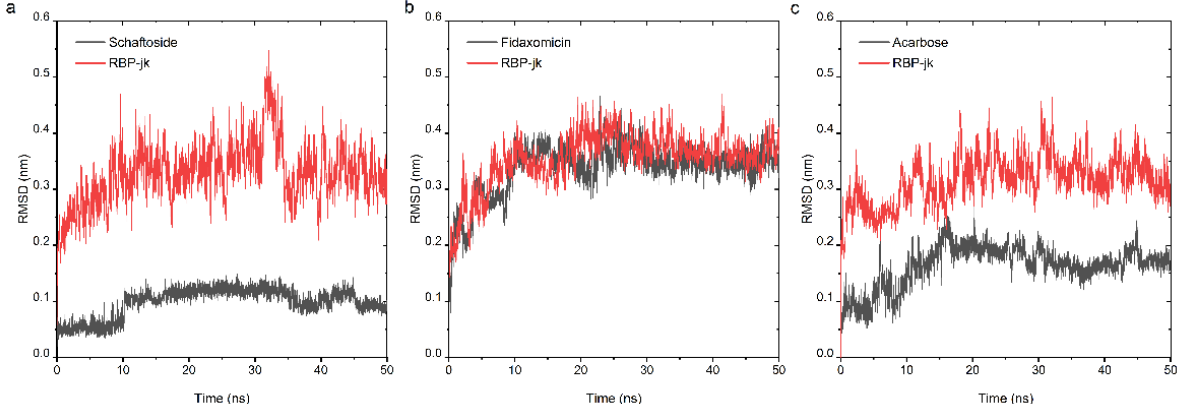
Figure 4. Analysis of RMSD trajectories for the complex of the RBPJ protein and selected hit through- out 50 ns all-atom MD simulation. RMSD plots for schaftoside ( a ), fidaxomicin ( b ), acarbose ( c ) in complex with RBPJ were illustrated, respectively. Each compound was shown in black and RBPJ protein shown in red. RMSD, root-mean-square deviation.